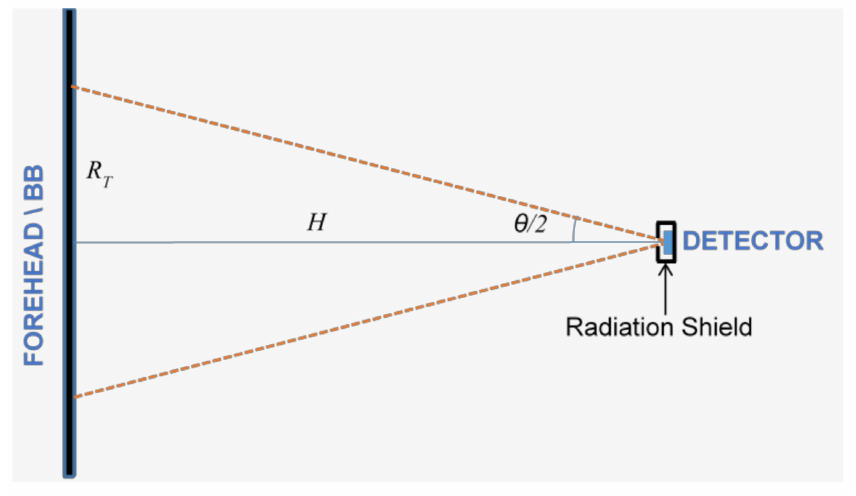
Figure 5. Radiometer with no